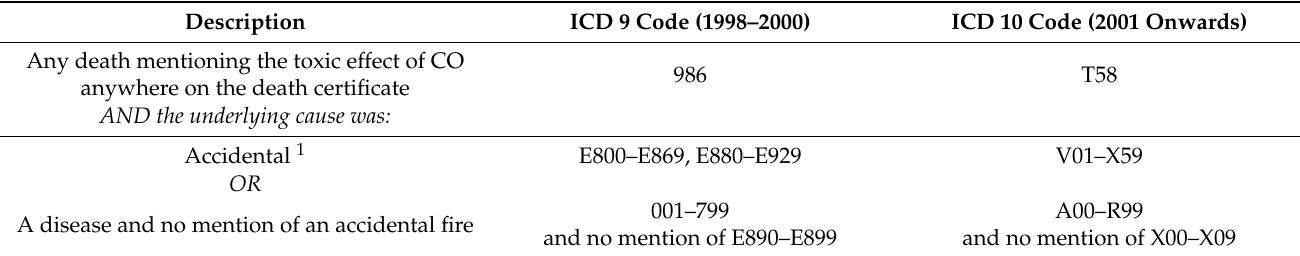
Table 1. The International Classification of Diseases (ICD) inclusion criteria for the narrative search on UNFR CO